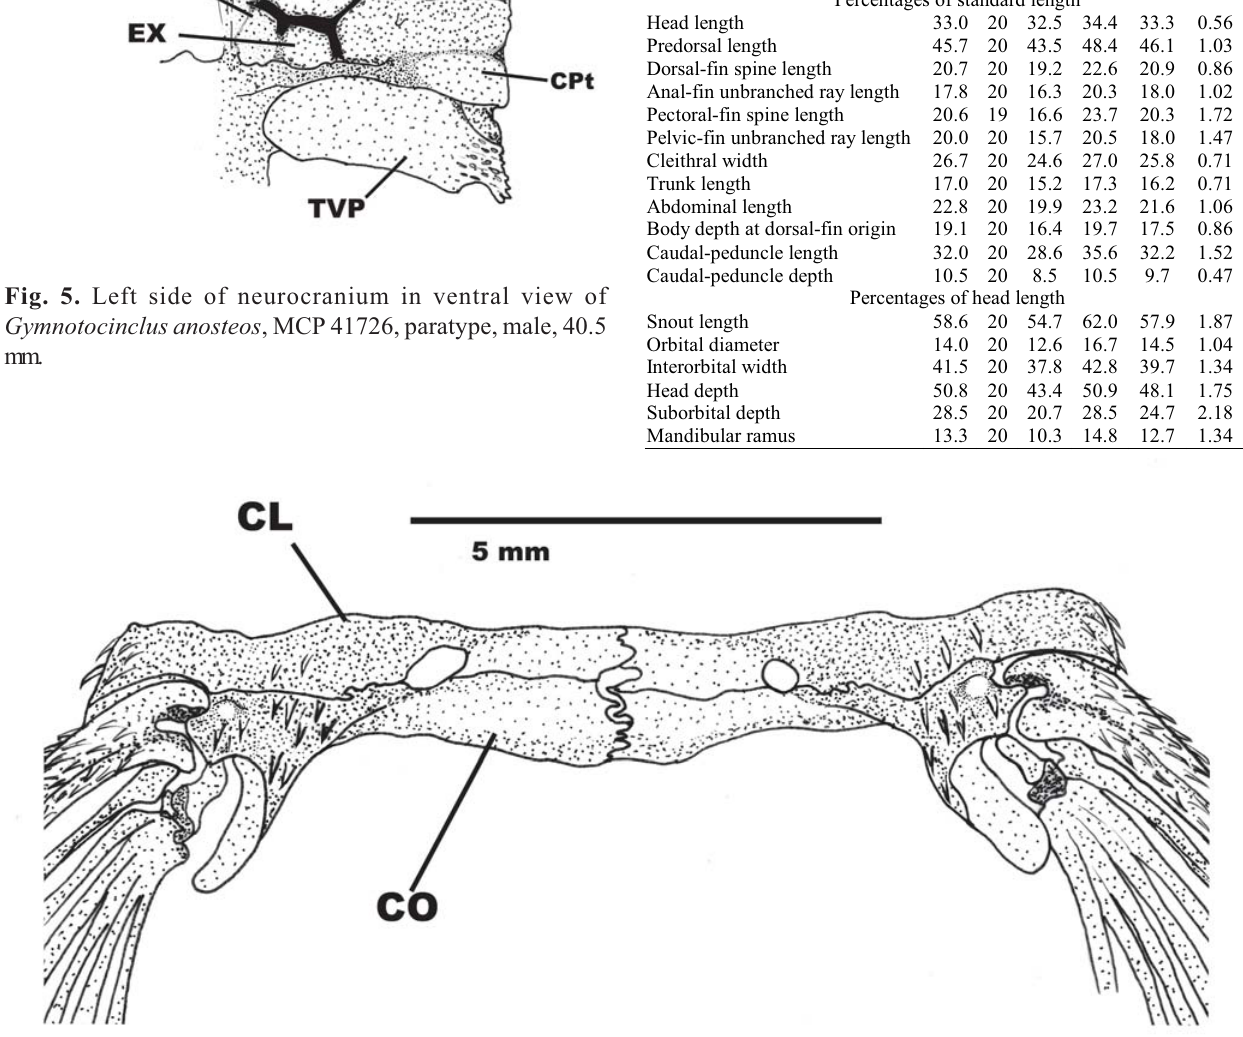
Fig. 6. Pectoral girdle in ventral view of Gymnotocinclus anosteos , MCP 41726, paratype, male, 40.5 mm.